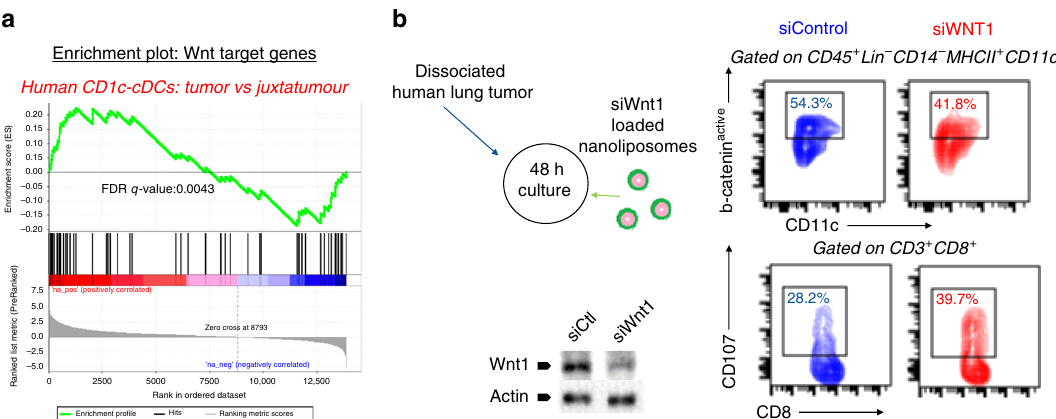
Fig. 7 Wnt1 silencing attenuates Wnt pathway activation in human LUAD cDCs. a Human CD1 − cDCs were sorted from primary lung adenocarcinomas and paired juxta-tumor healthy lung and analyzed by RNAseq. Gene Set Enrichment Analysis (GSEA) enrichment plot ( n = 4 per group). b Primary human lung adenocarcinomas were dispersed and total cells cultured in the presence of Wnt1-silencing RNA (siWnt1) or control siRNA loaded nanoparticles (Up). Wnt1 silencing was con fi rmed by western blot (bottom). Representative histograms showing active b-catenin in cDCs (up) and extracellular CD107 in CD8 + T cells (bottom). Data are representative of 3 independent experiments. Source data are provided as a Source Data fi le. Sequencing data are available with the accession code